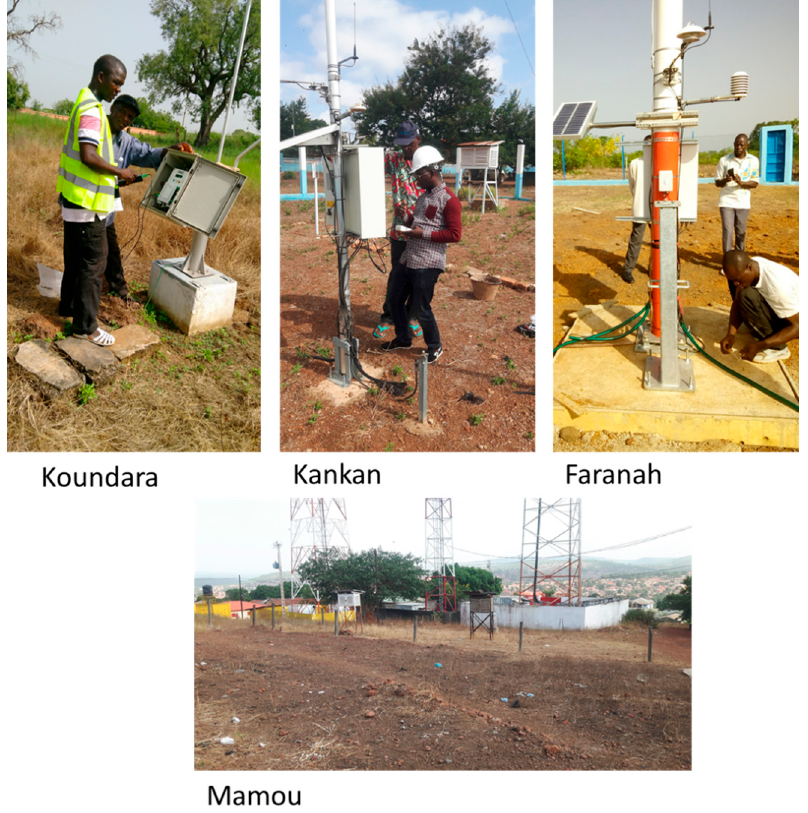
Figure A1. Photographs of observing sites (Koundara in the Northwest, Kankan in the Northeast, Faranah in the Center and Mamou in the Southwest Central regions of the country).